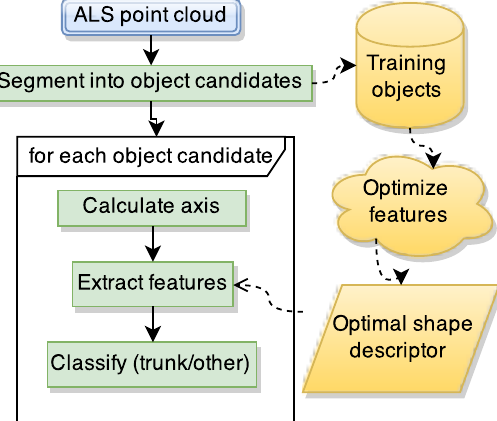
Figure 2: Overview of dead trunk detection pipeline.